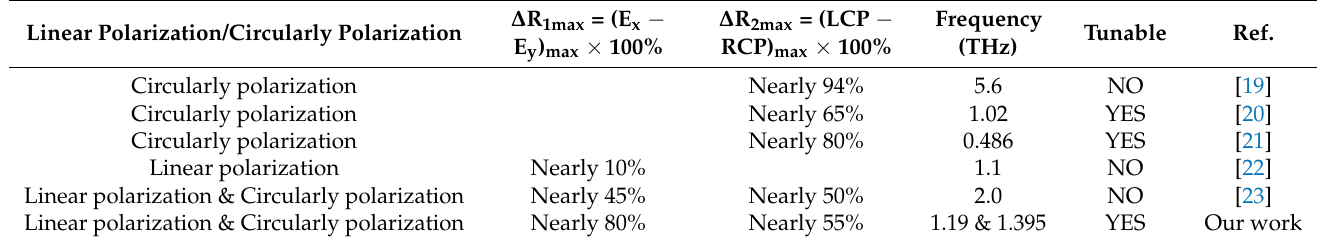
Table 1. Comparison results of the reflection differences in this paper with previous similar works.